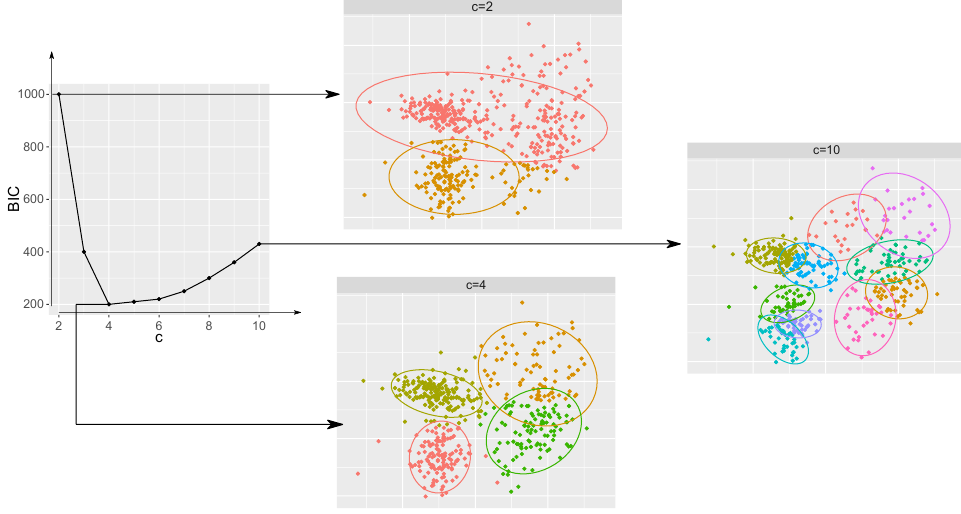
Figure 1. Model selection